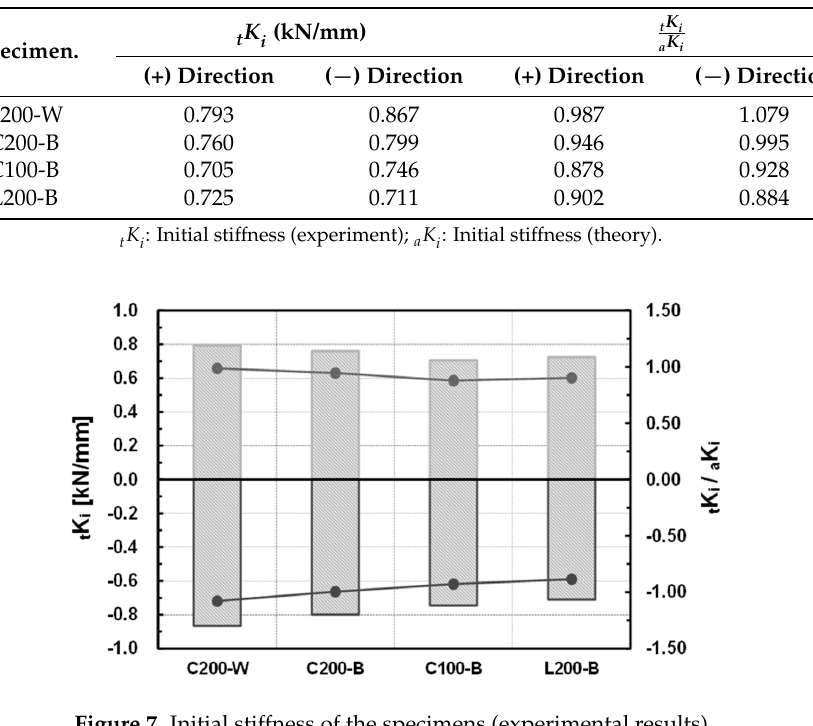
Figure 7. Initial stiffness of the specimens (experimental results).